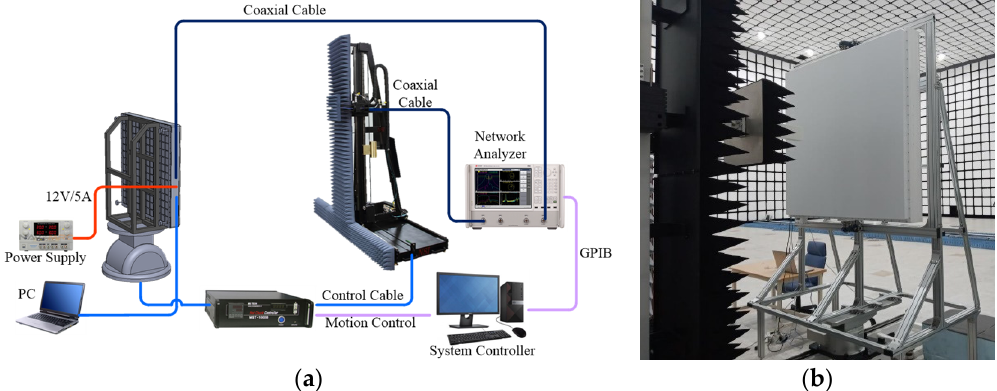
Figure 11. The near-field measurement system and the mounted antenna: ( a ) measurement setup and ( b ) its environments.